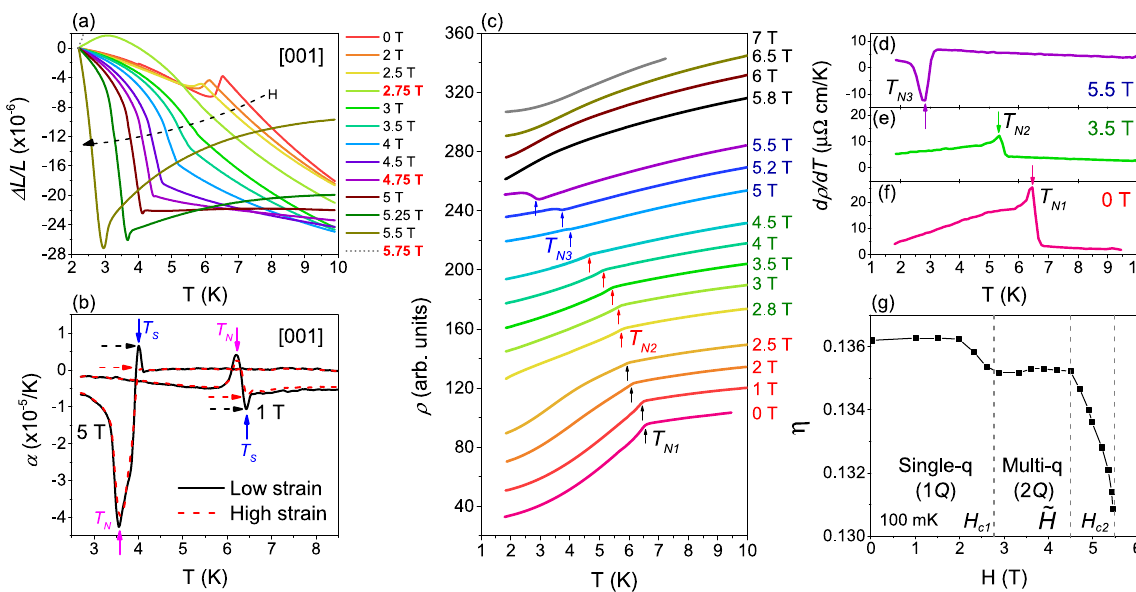
Fig. 2 Field evolution of phase transitions and ordering wave vector in CeAuSb 2 . a Temperature dependence of the thermal expansion of CeAuSb 2 along [001] at various magnetic fi elds applied along the c -axis. Labels in bold indicate H c 1 , ~ H , and H c 2 . b Temperature dependence of the linear thermal expansion coef fi cient along [001] with 1 and 5 T applied along the c -axis. The estimated pressure is 0.07 and 0.02 GPa for high-(dashed line) and low-(solid line) strain measurements, respectively. Solid arrows indicate peak positions: blue and magenta arrows for the T s and T N , respectively. Dashed arrows indicate points of minor peaks under low and high strains. c Temperature dependence of the in-plane electrical resistivity, ρ ab , of CeAuSb 2 for applied magnetic fi elds along c -axis. Data at different fi elds are shifted for clarity. Arrows indicate antiferromagnetic transition temperatures: black, red, and blue arrows for the T N 1 , T N 2 , and T N 3 , respectively. d – f Temperature derivative of ρ ab under applied fi elds as a function of temperature at 5.5 T ( d ), 3.5 T ( e ), and 0 T ( f ). g Magnetic ordering wave vector η [ r , l , u . ] for Q 1 = ( η , η , 1/2) in CeAuSb 2 as a function of magnetic fi eld applied along the c -axis at 100 mK. Data from ref. 20 were obtained by neutron diffraction measurement. Dashed lines at H c 1 , ~ H , and H c 2 separate three distinct regions. Error bars are smaller than the size of the data